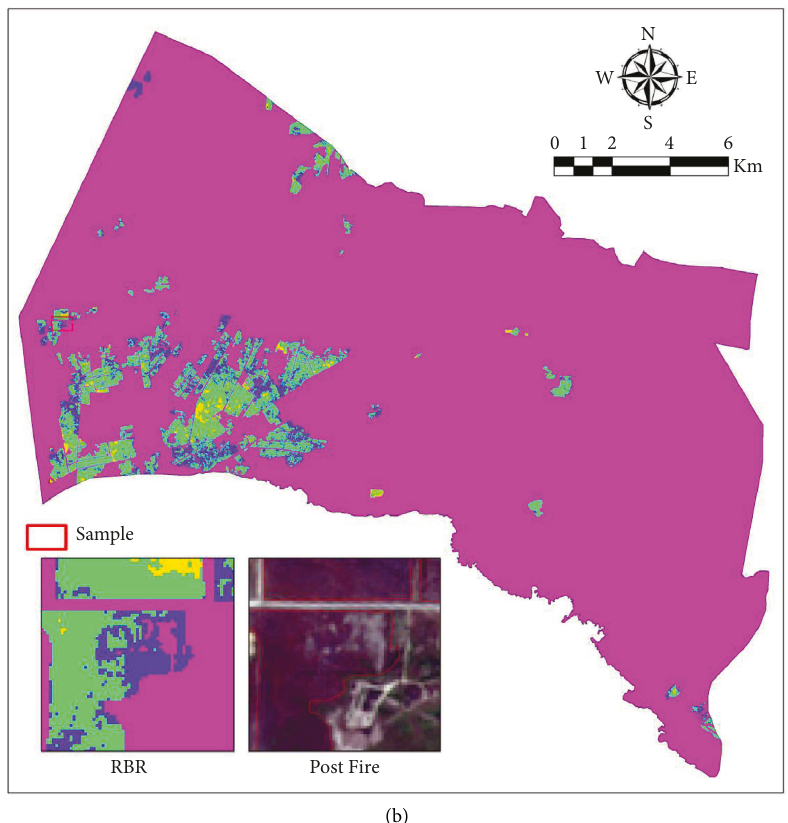
Figure 4: Visual validation of burned areas in